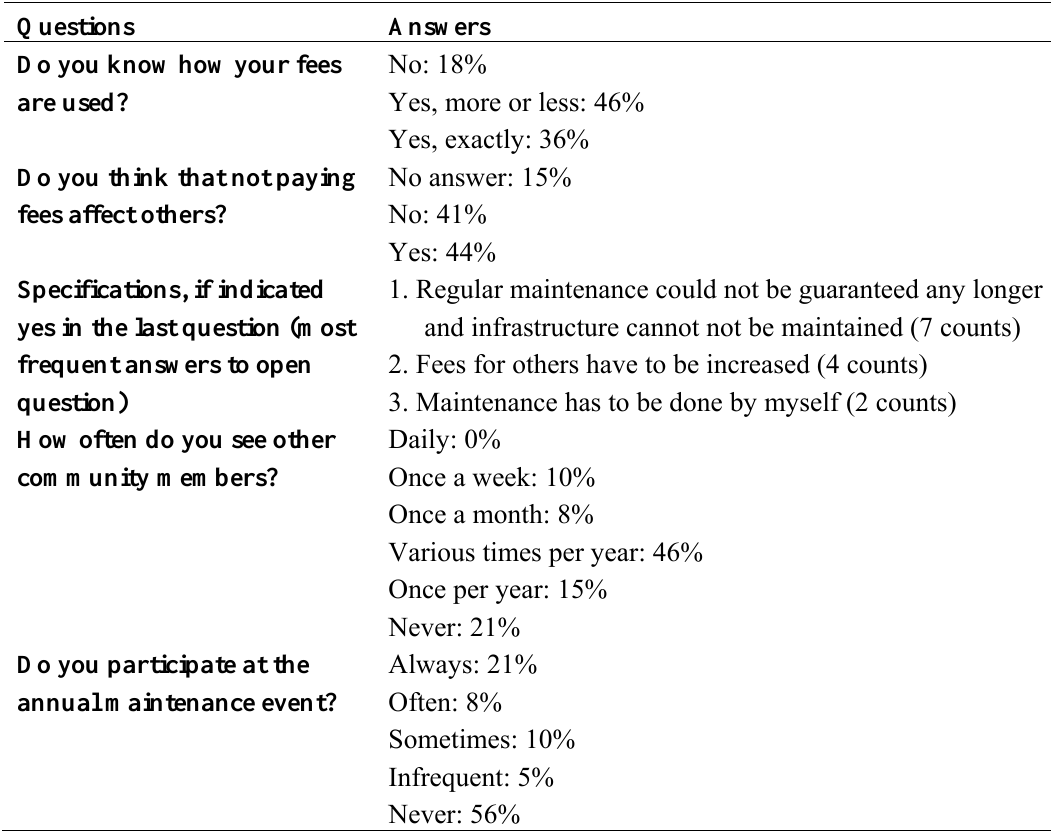
Table 4. Analysis of questions on knowledge and